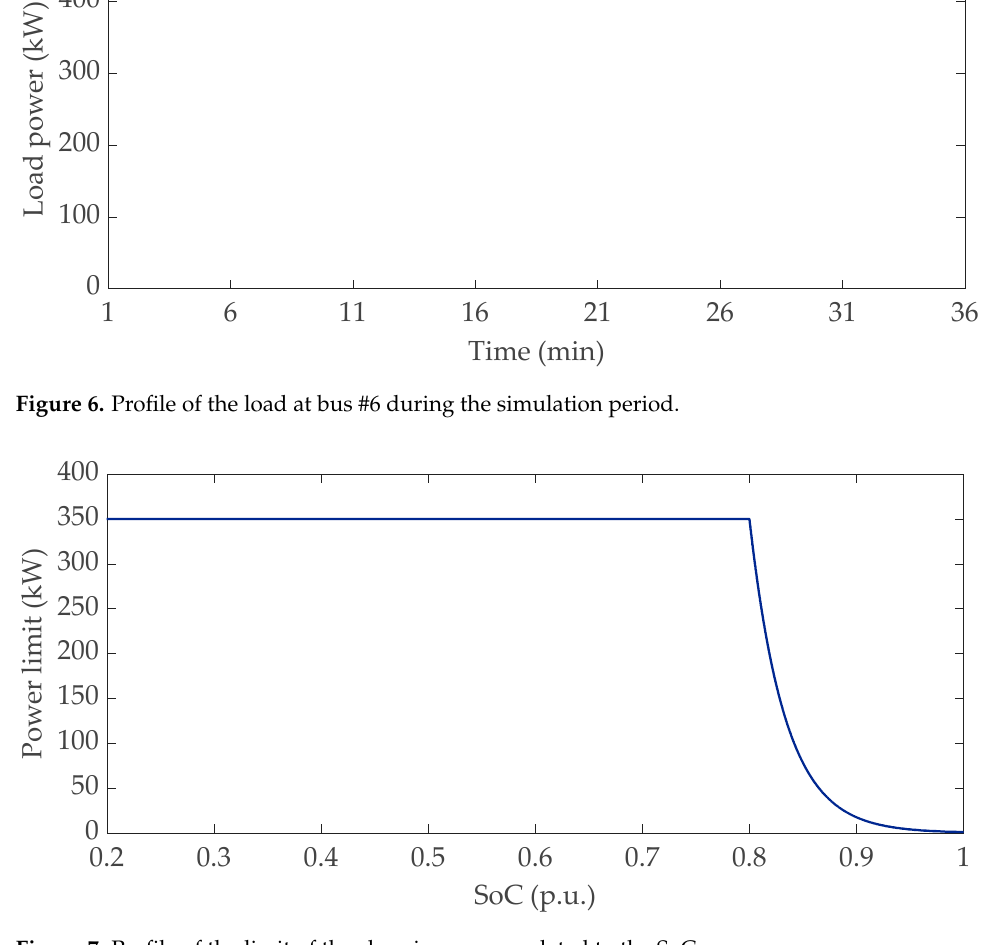
Figure 6. Profile of the load at bus #6 during the simulation period.